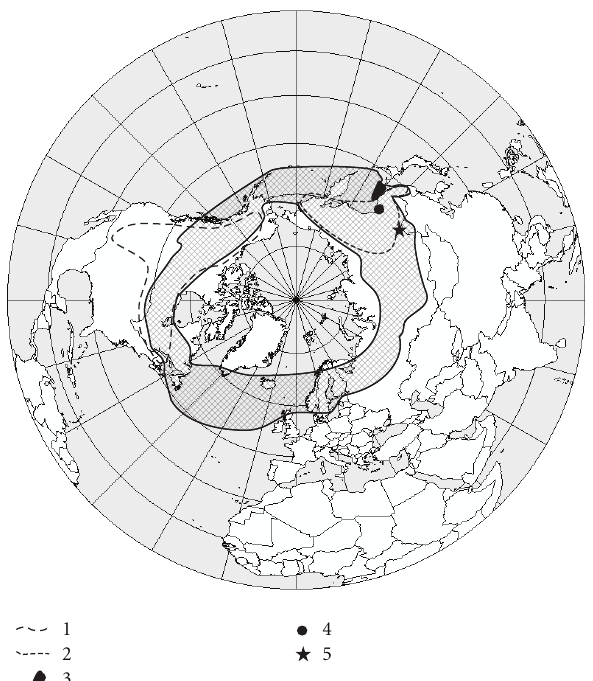
Figure 3: Distribution of the Chrysochraontini grasshoppers: Chloealtis conspersa (1), Podismopsis gelida (2), P. silvestris (3), P. insularis (4), and Chrysochraon amurensis (5) relative to the boreal